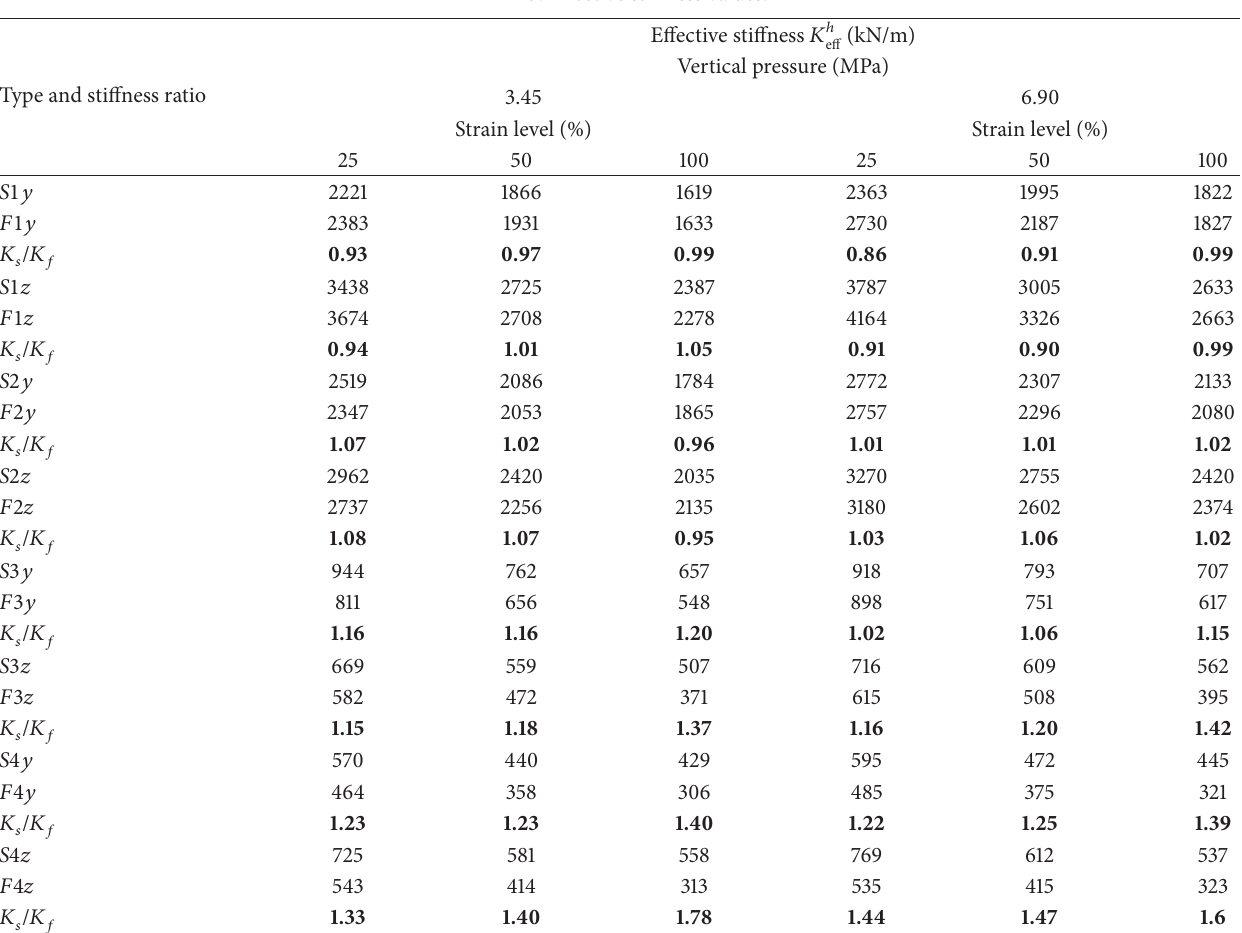
Table 3: Effective stiffness